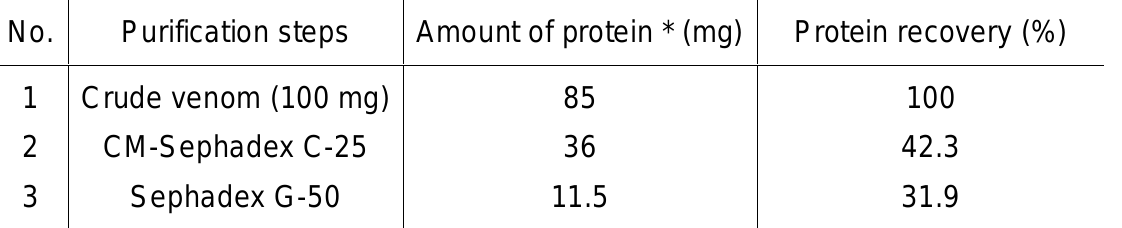
Table 1: Summary of the purification of toxins from scorpion ( Palamneus gravimanus ) crude venom